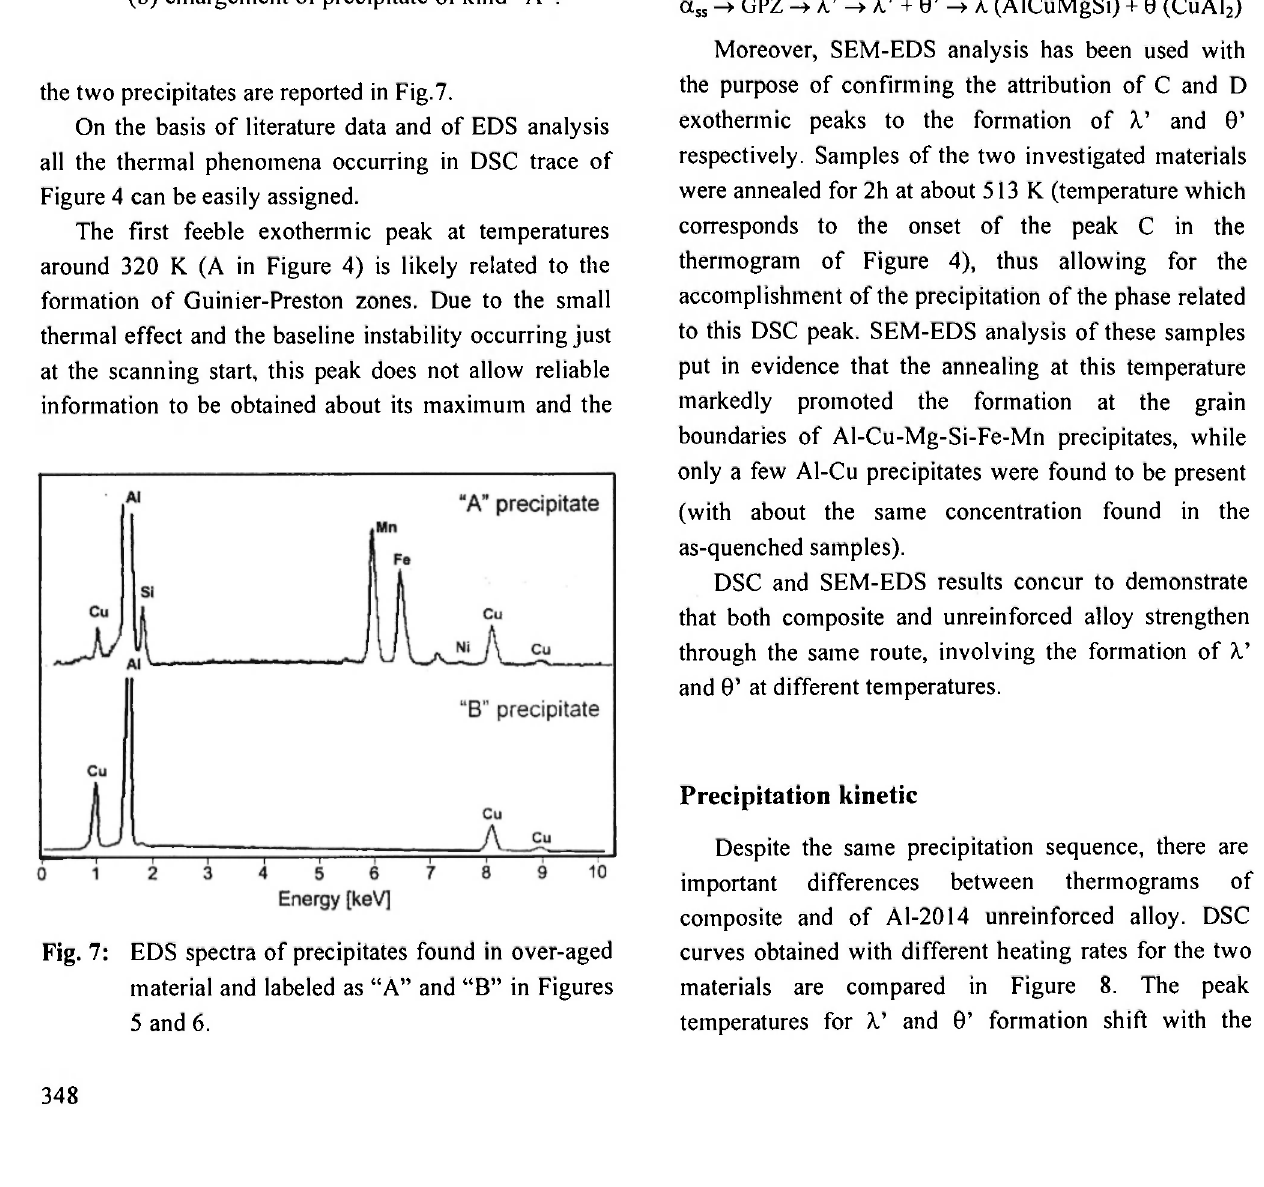
Fig. 6: Precipitates in over-aged Al 2014/Saffil composite: (a) different kinds of precipitates, (b) enlargement of precipitate of kind "A".